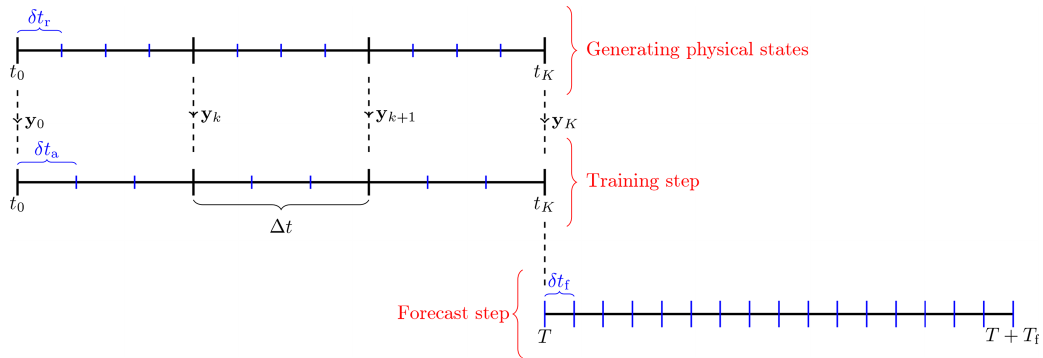
Figure 2. Schematic of the three steps of the experiments, with the associated time steps (see main text). The beginning of the forecast window may or may not coincide with the end of the training window. The lengths of the segments δt r , δt a , and δt f are arbitrary in this schematic.